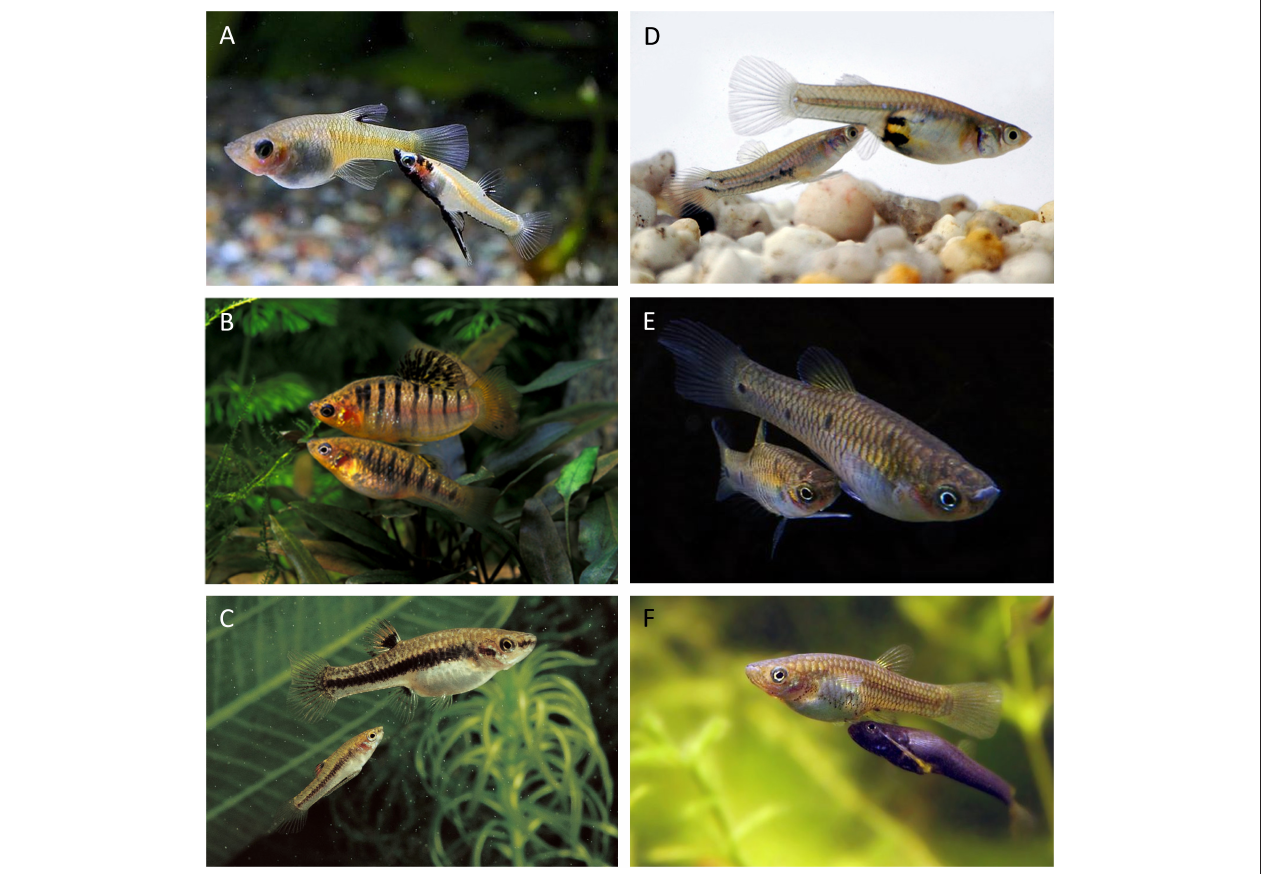
FIGURE 3 | Examples of male mating behavior in different poeciliid species. Courtship in (A) Girardinus metallicus and (B) Limia nigrofasciata . (C) A male Heterandria formosa approaches a female from behind, in this non-courting species. Mating attempts in the form of gonopodial thrusts in (D) Poecilia parae , (E) Phallichthys quadripuctatus , and (F) Poeciliopsis occidentalis . Photo credits: (A) https://acquariofiliaconsapevole.info/pesci_girardinus_metallicus, (B) Katie Holz, (C) TFH Archives, (D) Godfrey Bourne, www.discoverlife.org, (E) http://aquaria.palo-alto.ca.us/, (F) Dennis